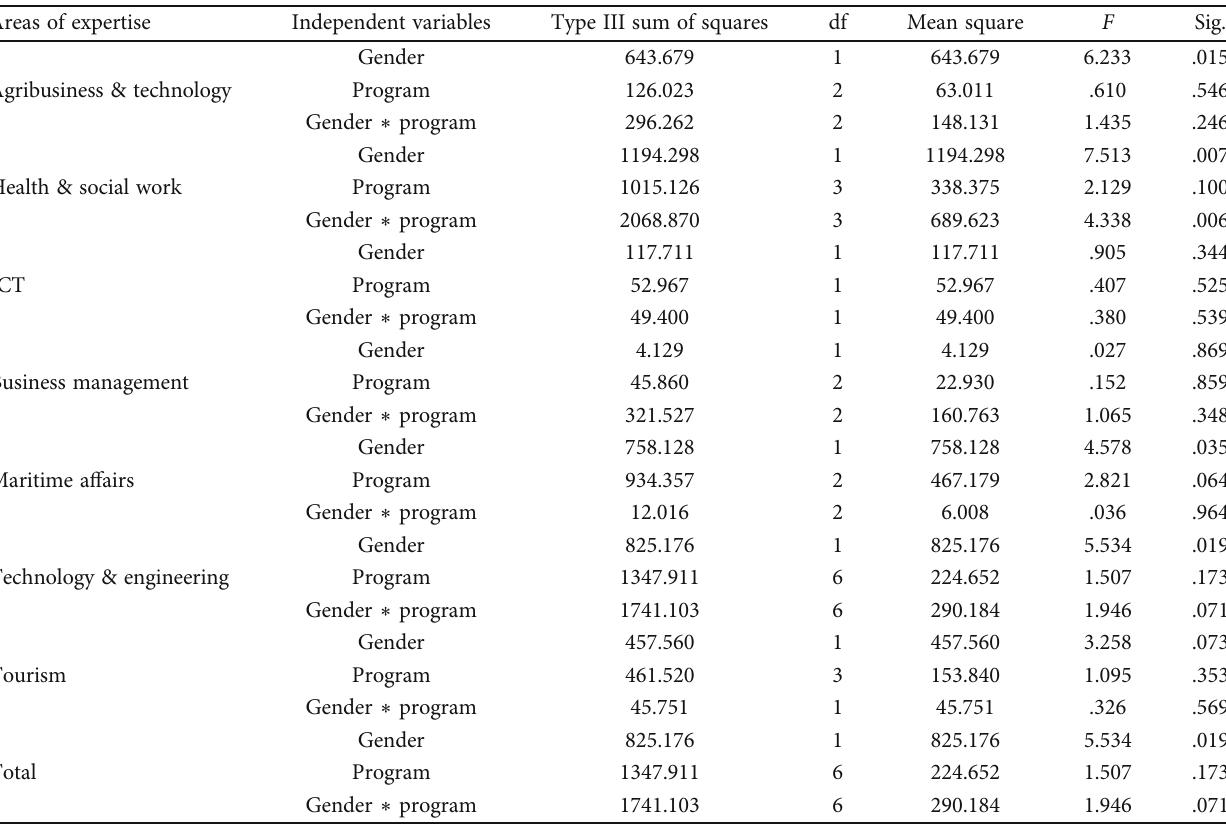
Table 3: The results of the multivariate analysis of variance on the interaction of variables of gender and con fl ict in expertise programs on students ’ ESE